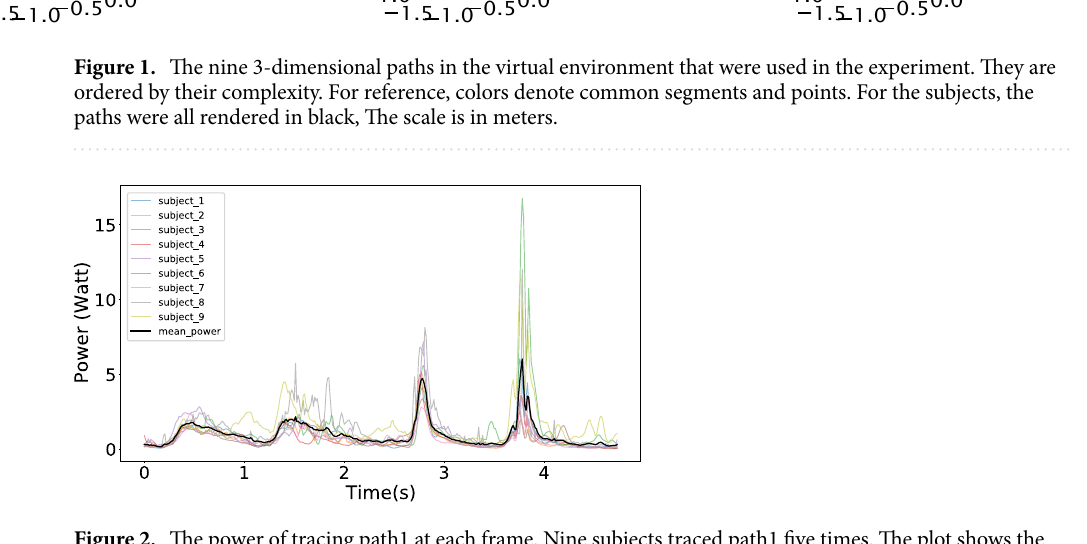
Figure 2. The power of tracing path1 at each frame. Nine subjects traced path1 five times. The plot shows the average joints’ power at each frame for each of the subjects in a color. The black line indicates the mean. The common curve similarities indicate that different subjects had similar power patterns while tracing the same curve, which shows that each subject has difficulty in tracing at the same point in the trace. Path 1 is the most straightforward, but the observation of correlated effort represents patterns in tracing other